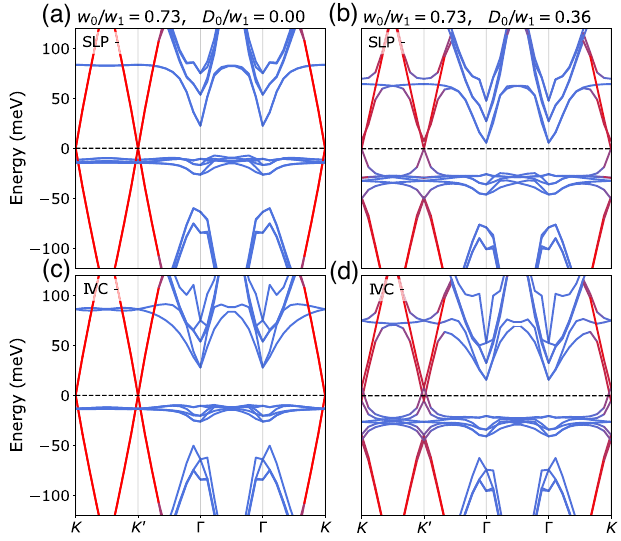
FIG. 6. HF band structures at ν ¼ 2 for the spin-polarized SLP − state (a) at D 0 ¼ 0 and (b) D 0 > 0 and spin-polarized IVC − state (c) at D 0 ¼ 0 and (d) D 0 > 0